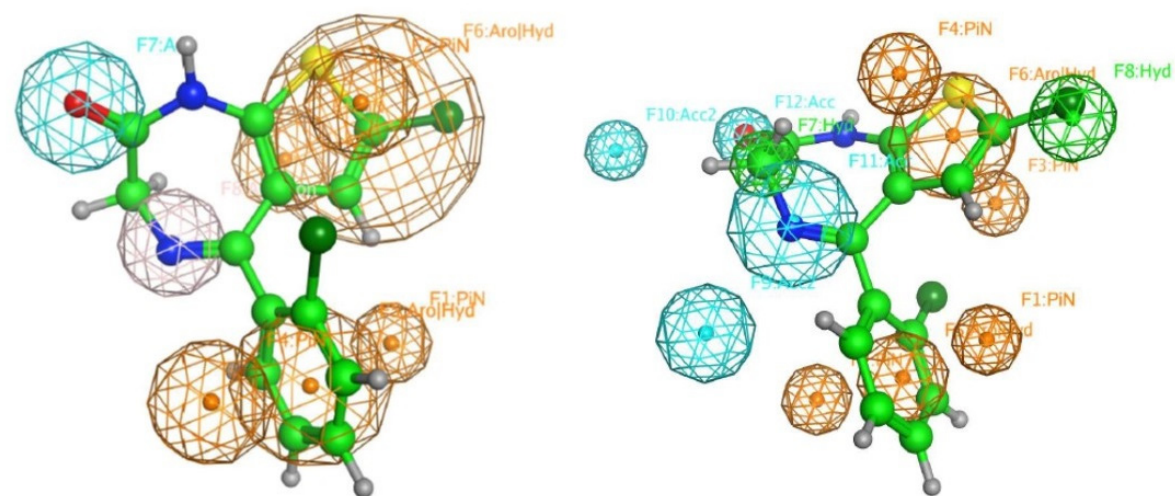
Figure 9. Pharmacophore queries generated for 6HUO and 6HUP. Notes: On the left side, the pharmacophore query obtained from the flexible alignment of the ten DBZDs docked in the 6HUO binding site is presented. Conversely, the one obtained from the flexible alignment of the ten DBZDs in the 6HUP binding site is provided on the right side. In both images, at the centre of the pharmacophore, and represented in green, is the molecule that showed the highest predicted value of log1/C, Ro 09-9212. Different colours were used to identify heteroatoms in the structure, specifically yellow for sulphur (S), red for oxygen (O) and blue for nitrogen (N).